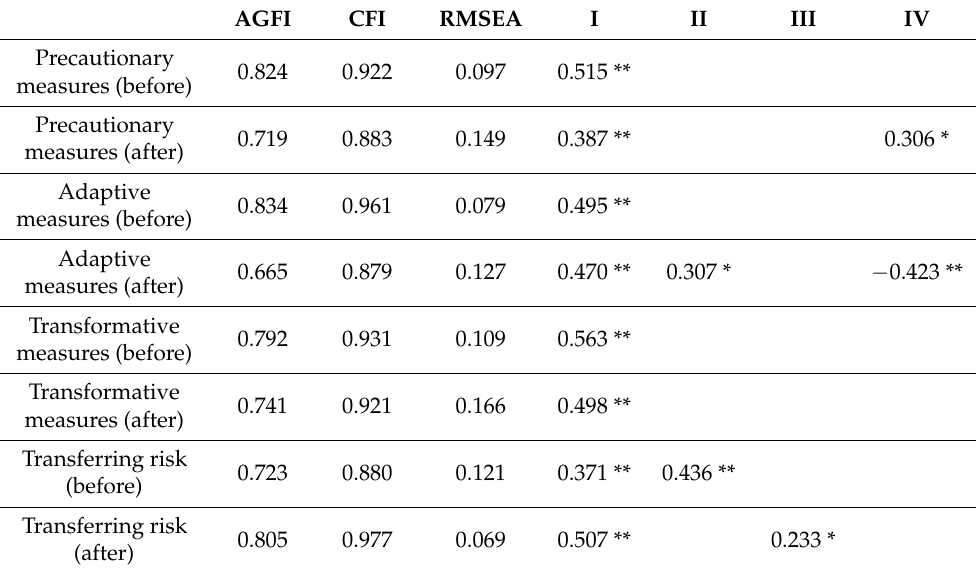
Table 10. Goodness-of-fit indicators and standardized path coefficients for covariance structure model analysis